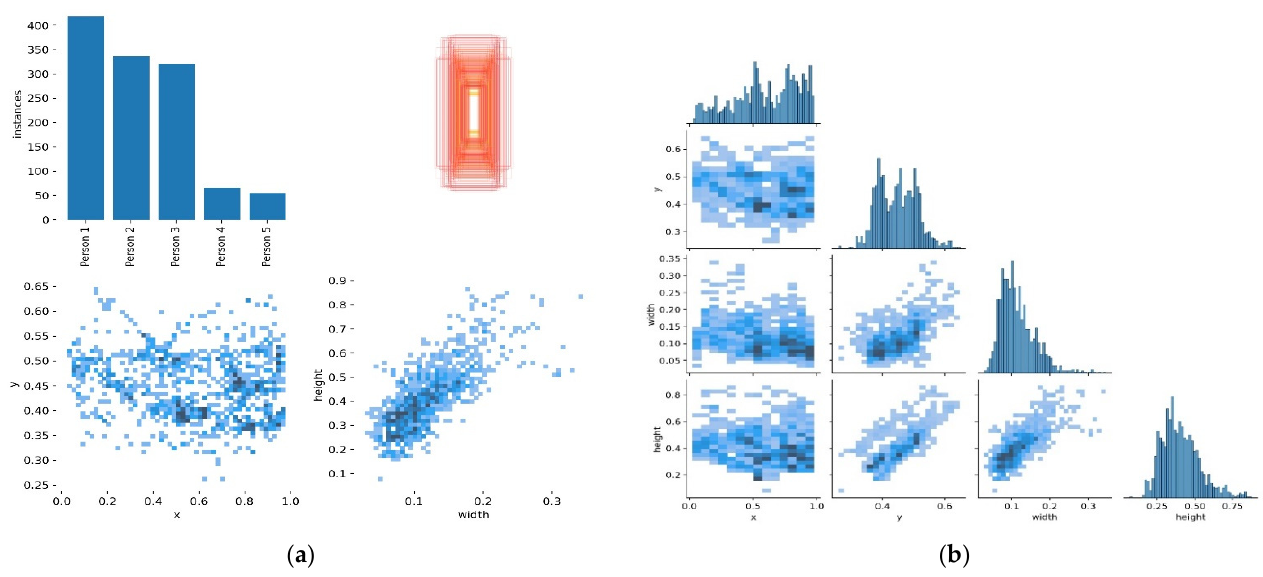
Figure 3. The left ( a ) shows the scatter plot of each instance and label associates, and ( b ) illustrates the correlation relations on the campus scenes images dataset. At most, 90% of the instances are correctly associated with the labels throughout the scenes.